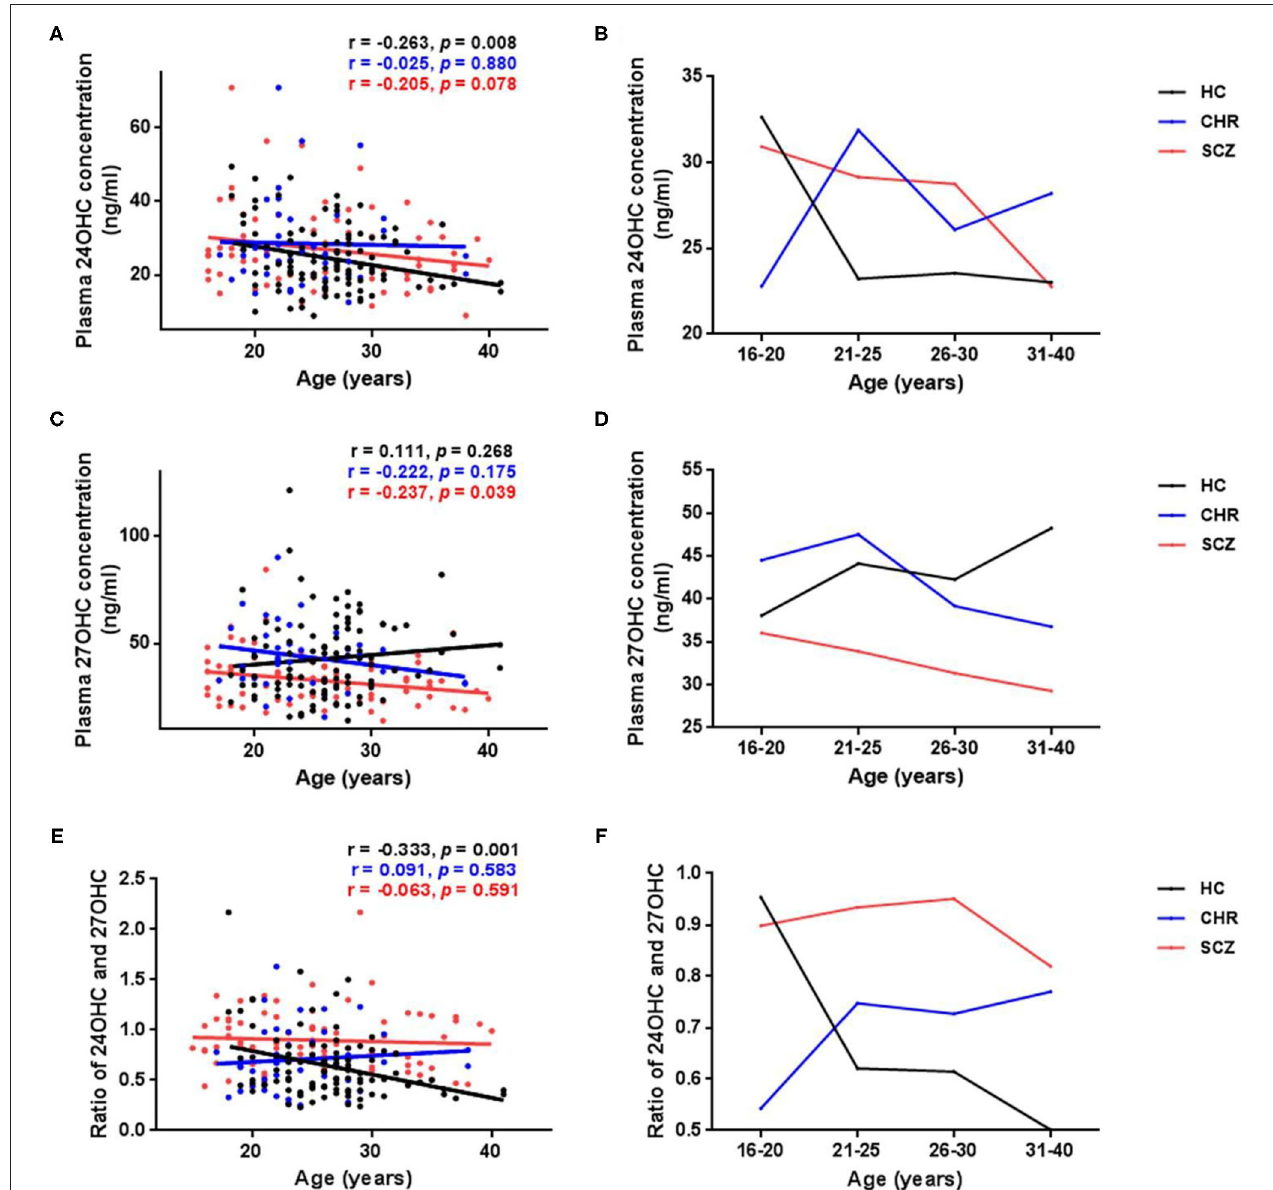
FIGURE 2 | Age-related changes of plasma levels of oxysterols in schizophrenia (SCZ) patients, clinically high risk (CHR) individuals, and healthy controls (HC). (A,B) Absolute values of 24OHC at different ages; (C,D) Absolute values of 27OHC at different ages. (E,F) Ratio of 24OHC and 27OHC at different ages. Significant age-dependent decreases of 24OHC levels and 24OHC/27OHC values were found in the HCs. Opposite trend of 24OHC levels and 24OHC/27OHC values along with age were found between HCs and CHR individuals or SCZ patients, and the largest difference occurs before 25 years old. Plasma 27OHC levels showed significant age-dependent decrease in the SCZ group. Unlike 24OHC, the difference in 27OHC between patients and HCs became more and more significant with the increase of age.